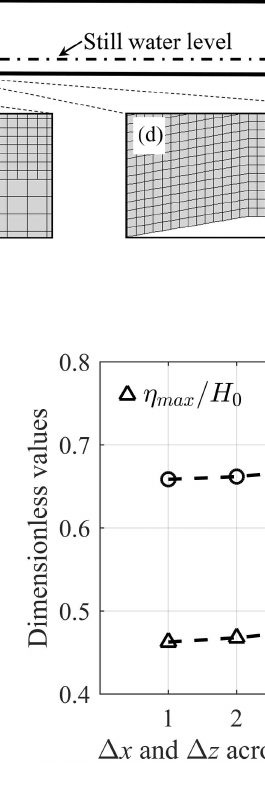
Figure 3. Variation of the maximum dimensionless free-surface el- evation ( η max /H 0 > 1) and streamwise velocity ( u max / at G7 with the grid size ( (cid:49)x and (cid:49)y ) across the reef for case 3